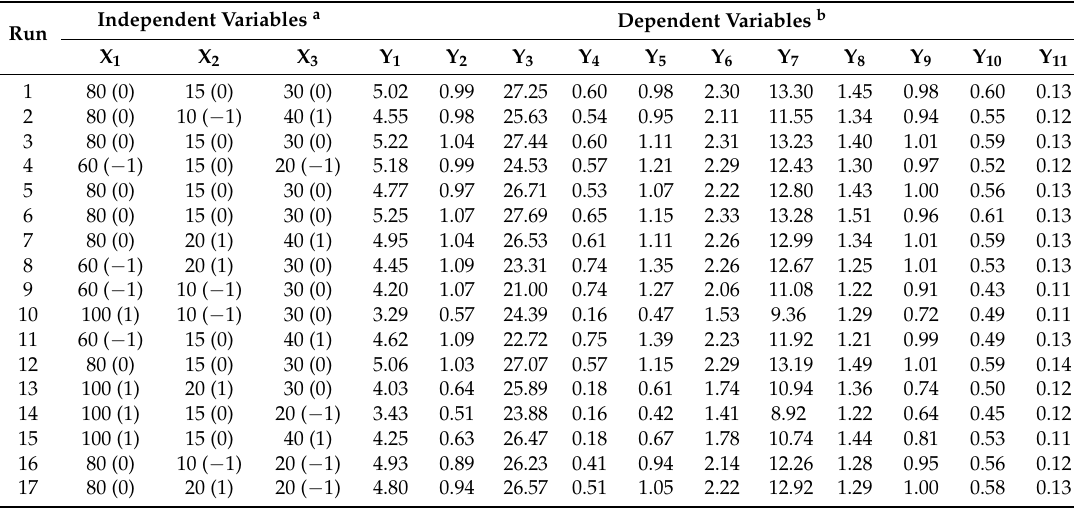
Table 1. Experimental results of the Box-Behnken design ( n = 3).